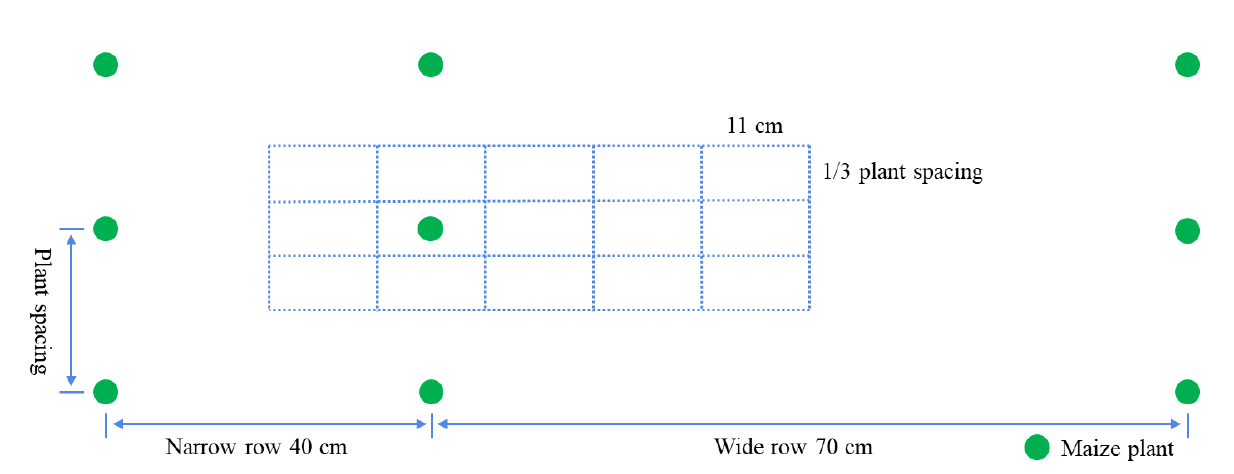
Figure 1. Schematic diagram of single maize plant root sampling.